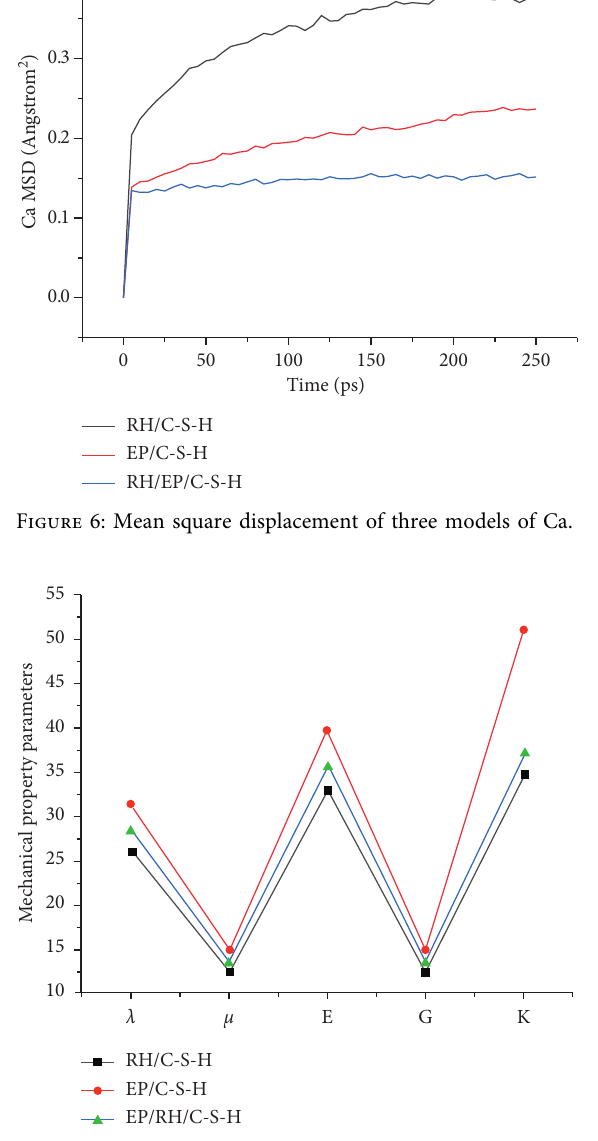
Figure 7: Main mechanical property parameters of three